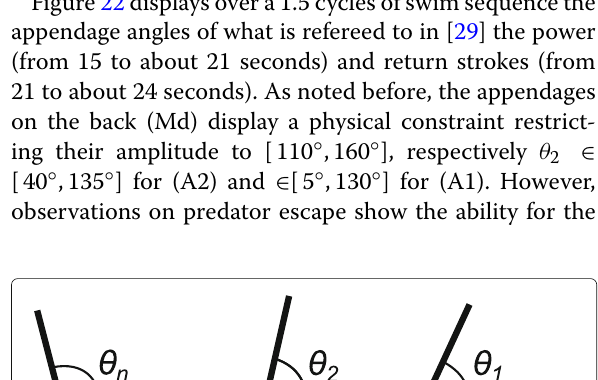
copepod (stage 5 nauplius) by the authors of [29]. On Fig. 21 experimental data and model output for a four- cycle swim episode can be seen with the angular measure- ments used as model input for the theoretical prediction (gray line) shown in bottom picture. It can be observed